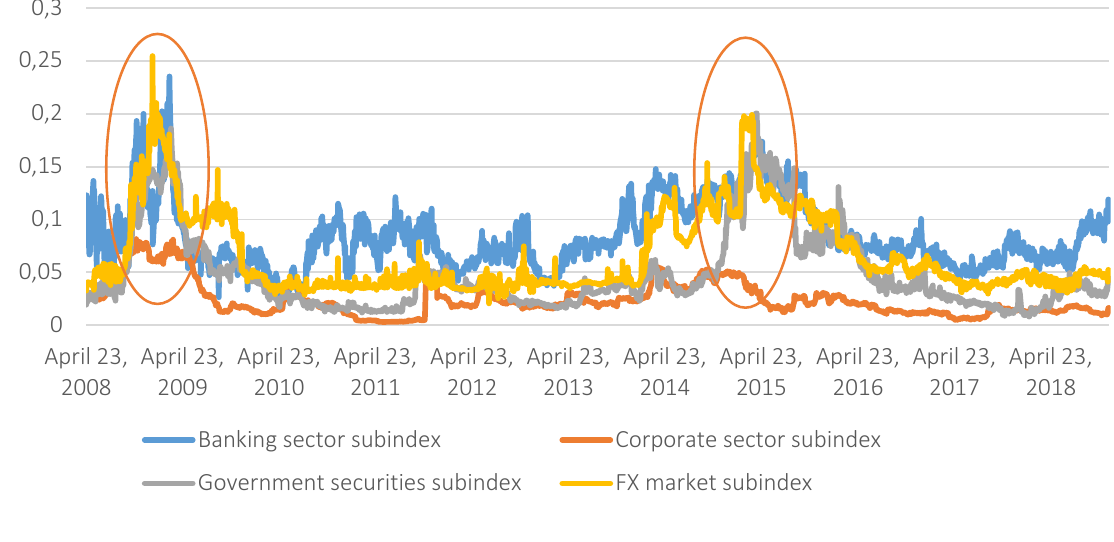
Figure 4. The Financial Stress Index for Ukraine,